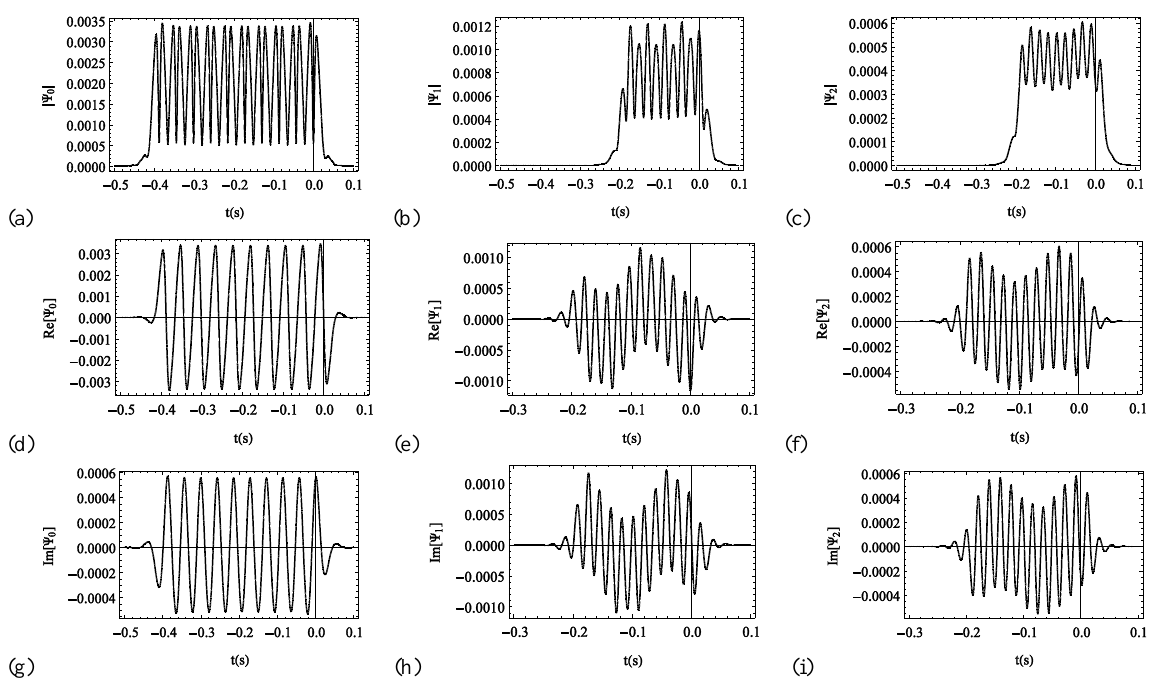
Fig. 6. Terms of Adomian’s decomposition for the angular